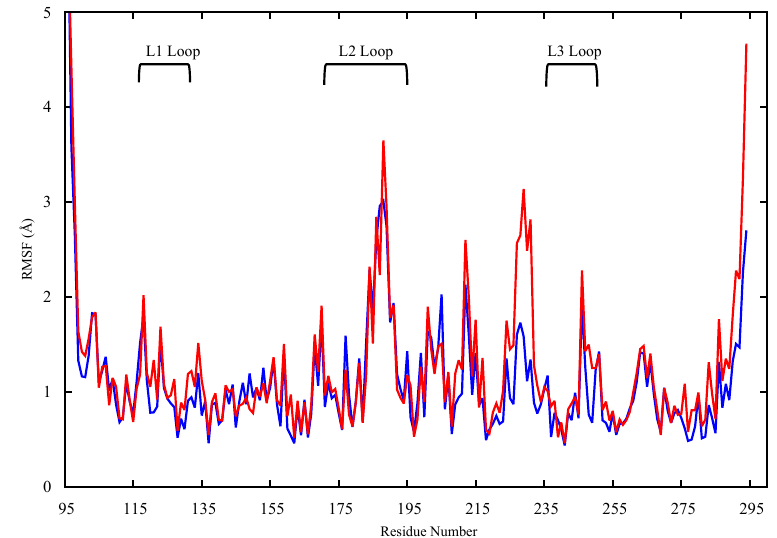
Figure 6. The RMSF plot for the backbone atoms of monomer B in the p53 dimer. Residues Glu224, Val225 and Gly226 have higher fluctuations in G245S-mp53 compared to wt-p53.